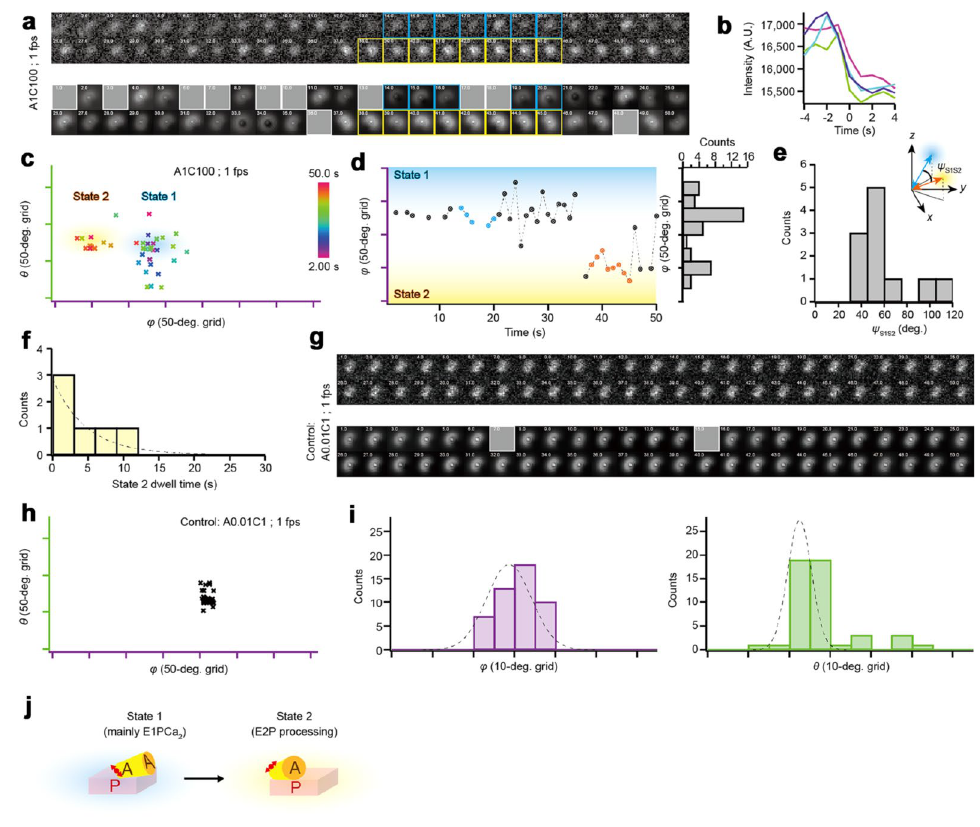
Figure 4. Measurement of the ATP-dependent angle change of the SERCA1a A-domain. ( a ) Sequential defocused images of a fluorophore at 1 µM ATP and 100 µM Ca 2+ (A1C100; cf. Supplementary Video 1). Time scale described in upper left of each image is in seconds. ( Upper panel ) Experimental images were taken at 1 s intervals. Approximately half of the molecules showed two dwell states (cyan and yellow frames correspond cyan and orange points in ( d ), respectively). ( Lower panel ) Reconstructed images represent the diffraction pattern rendered using the angles derived from the matching algorithm. Frames covered with gray square are eliminated frames where the matching algorithm failed to estimate angles or estimated incorrect values. ( b ) Typical intensity change of four molecules showing a single bleaching step. ( c ) The θ and φ angles of the fluorophore at 1 µM ATP and 100 µM Ca 2+ . The color of each point represents the time, as shown in the color bar. Note that the θ and φ angles are relative because the orientation of the SERCA1a molecule is not controlled in our system. ( d ) Time course of the φ angle of the fluorophore at 1 µM ATP and 100 µM Ca 2+ . ( Right ) Histogram of the φ angle. The two populations represent the states 1 and 2. ( e ) Histogram of ψ S1S2 angle between the two dwell states [e.g., ψ S1S2 angle is calculated as 58.8° using cyan and orange points in ( d )]. The calculated ψ S1S2 angle is 59.5° ± 24.3° ( n = 11 molecules). Inset schematically shows the definition of the ψ S1S2 angle. ( f ) A histogram of the dwell time of State 2 ( n = 6 dwells from 6 molecules). Dotted line indicates exponential fits of which the rate constant was ~ 0.2 s −1 . ( g ) Control: Sequential defocused images of a fluorophore at 0.01 µM ATP and 1 µM Ca 2+ taken at 1 s intervals (A0.01C1). In this condition, almost all the molecules are in the E 1Ca 2 state, but due to the suboptimal ATP concentration cannot form E P. Not a single molecule showed a change in angles. ( h ) The θ and φ angles of the fluorophore in ( g ). ( i ) A histogram of the φ and θ angle. The dotted line indicates the Gaussian fit, where σ φ = 5.5°and σ θ = 2.9°. ( j ) Schematic of the motion of the A-domain, based on the observation in this figure ( a – f ). This large azimuthal rotation of fluorophore most likely represents the large azimuthal rotation of the A-domain (see “Discussion”